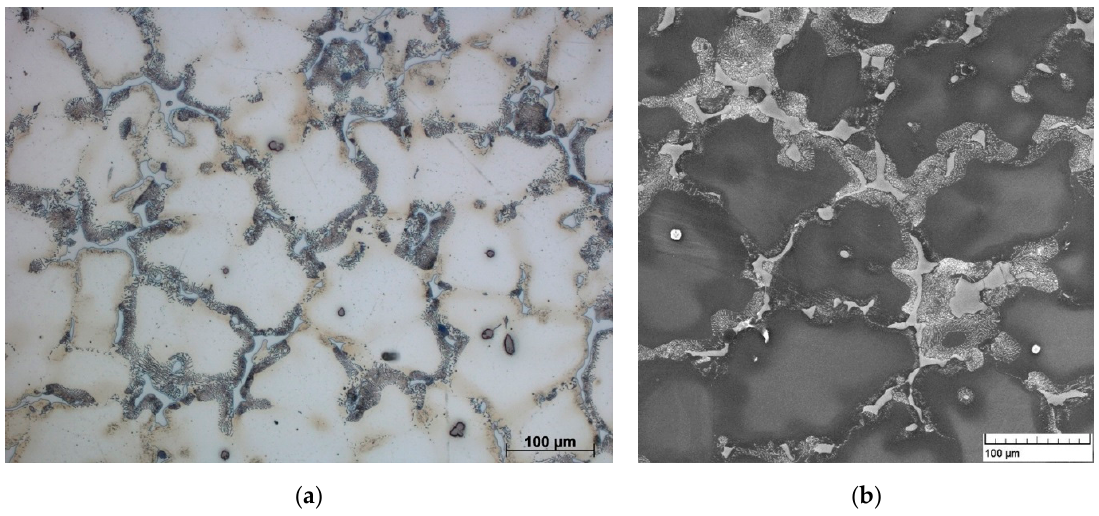
Figure 3. Microstructure of the AZ61 alloy in the initial state. ( a ) Light micrograph. ( b ) Electron micrograph. Picric acid was used for etching.